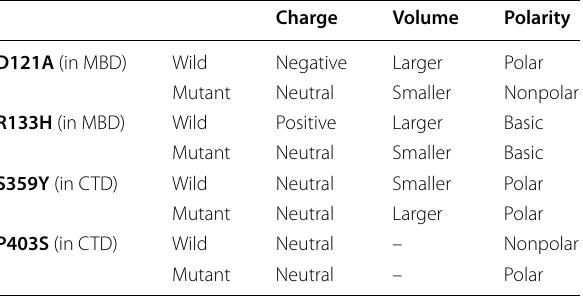
Table 3 Physical‑chemical properties of wild and mutant amino acids